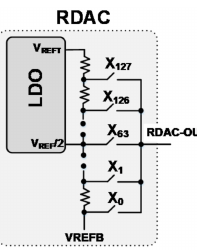
Figure 11. Reference voltages are decided and controlled by a low drop-out (LDO) voltage regulator.